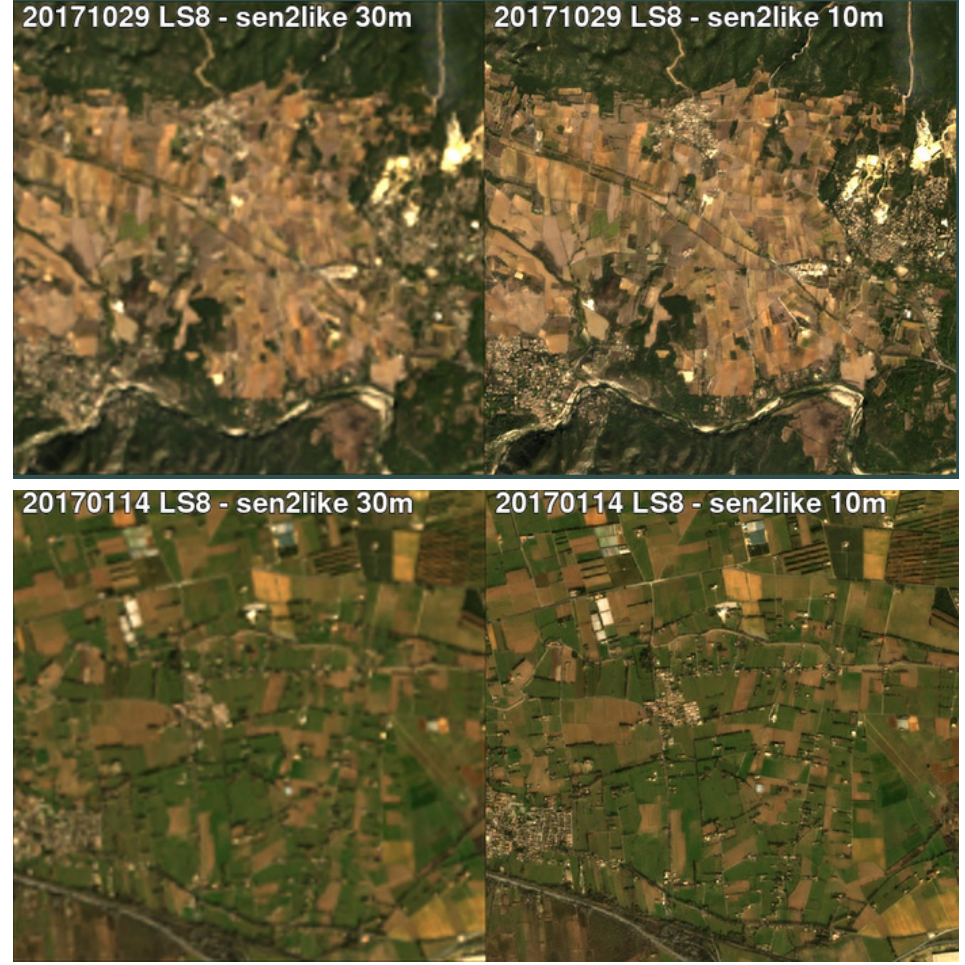
Figure 14. Thirty meter LS8 ( left ) and 10 m LS8 L2F ( right ) images over a valley ( above ) and crop fields ( below ).